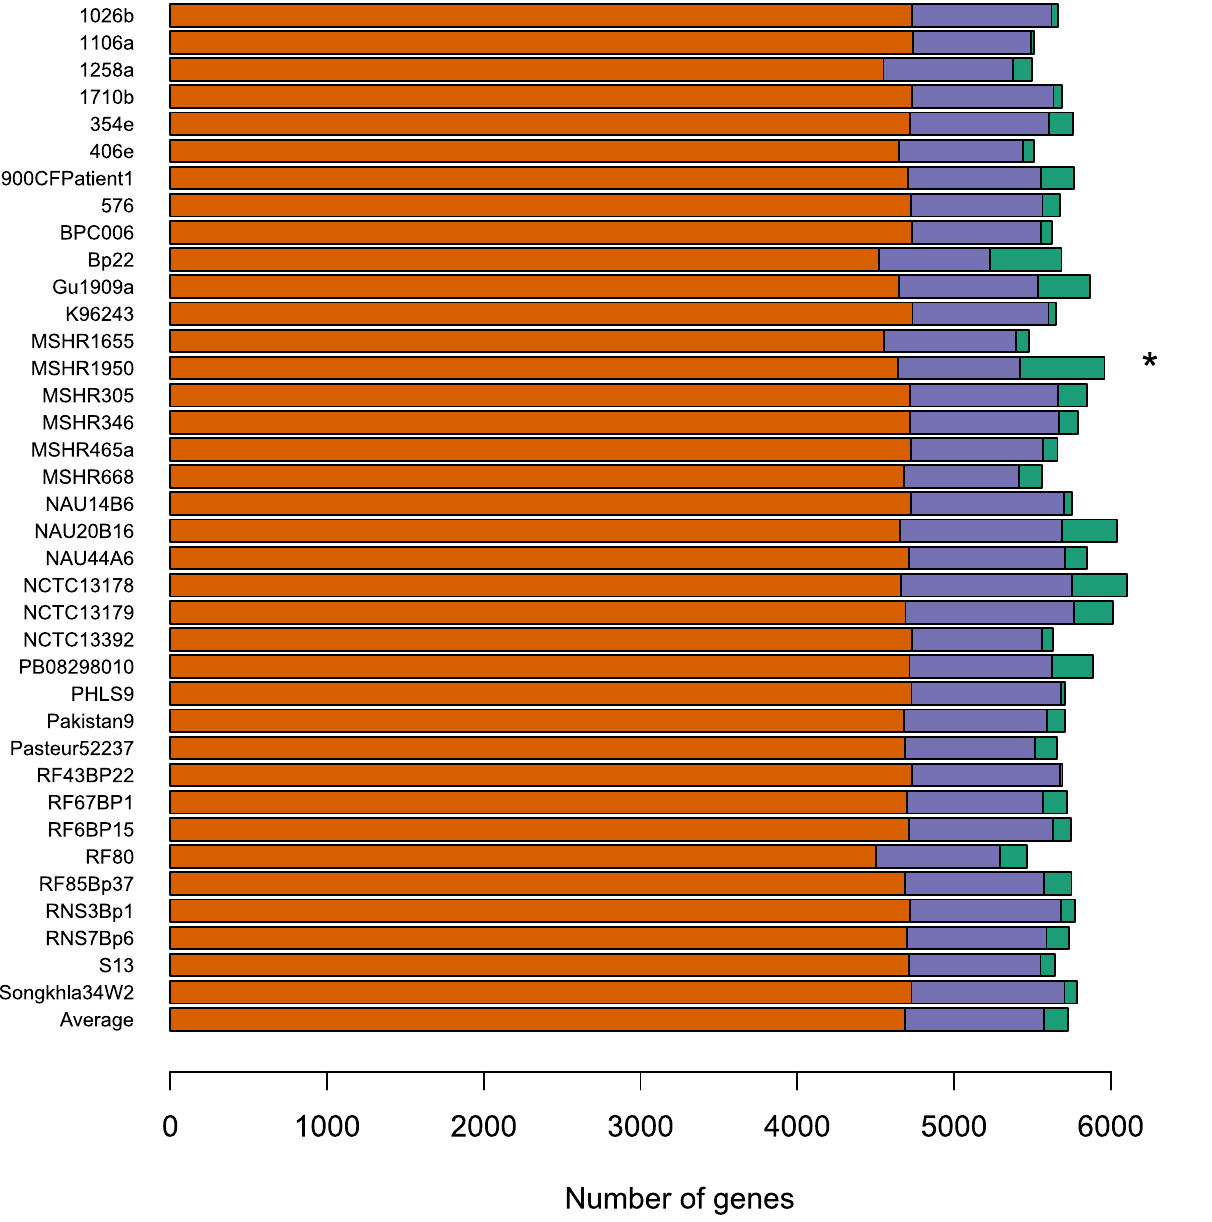
Fig 1. Genomic composition. Number of core (orange bars), character (purple bars), and unique (green bars) genes in 37 genomes. * MSHR1950 contains a 131kb